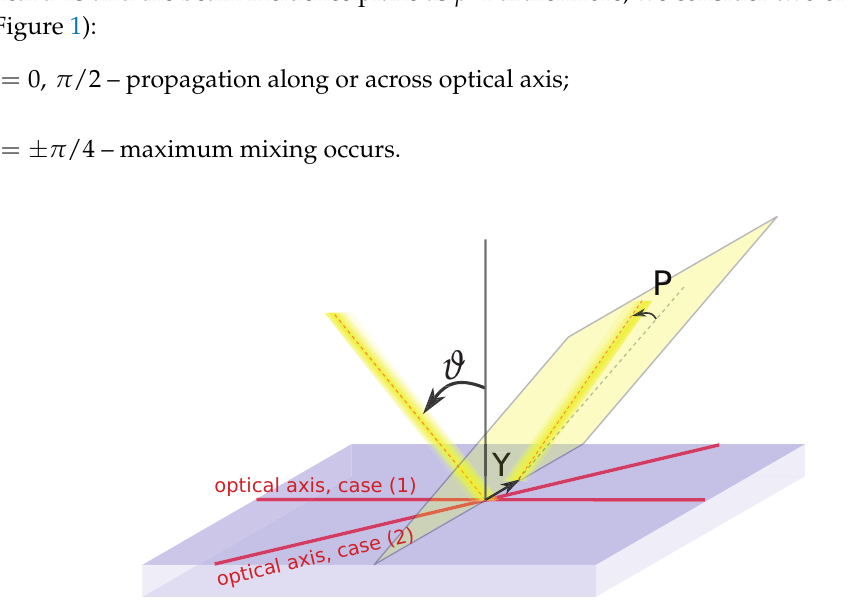
Figure 1. Geometry of the problem demonstrating schematically the beam incident on uniaxial medium at angle ϑ , when optical axis is parallel (case 1) or rotated by an angle π /4 with respect to beam incidence plane (case 2). Y and P show the linear and angular IF shifts,